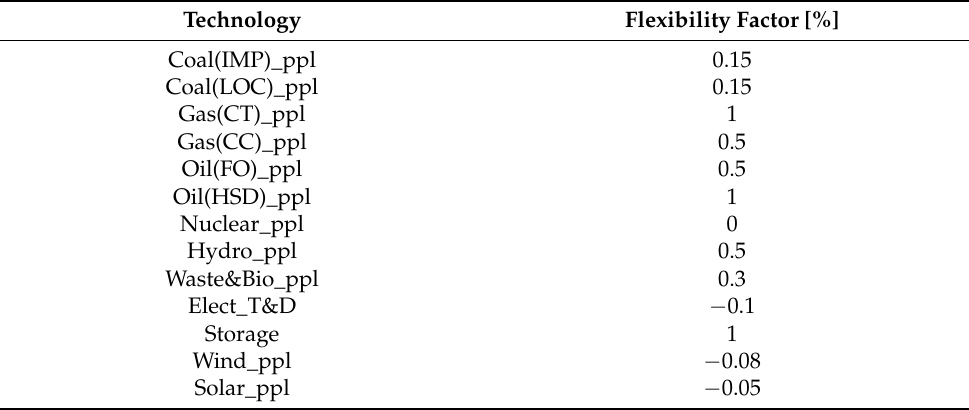
Table 4. The flexibility factors used in the MESSAGE model in this